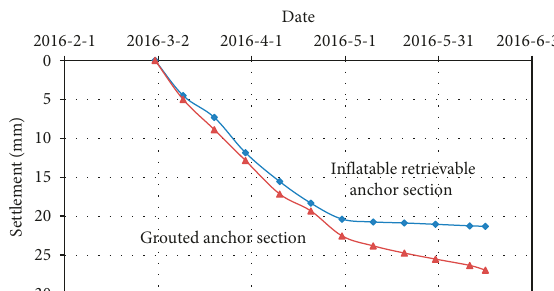
Figure 12: Settlement of surrounding buildings of two